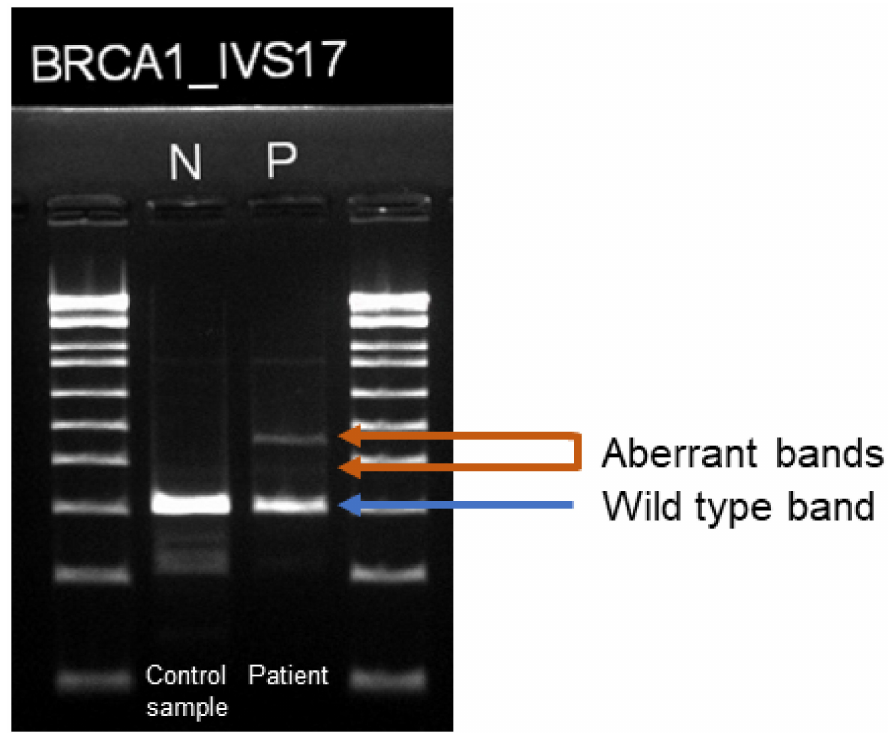
Figure 2. Electrophoresis of the RT-PCR product of RNA from the patient’s peripheral blood. Two faint bands (marked with orange arrows) can be seen in addition to the wild type